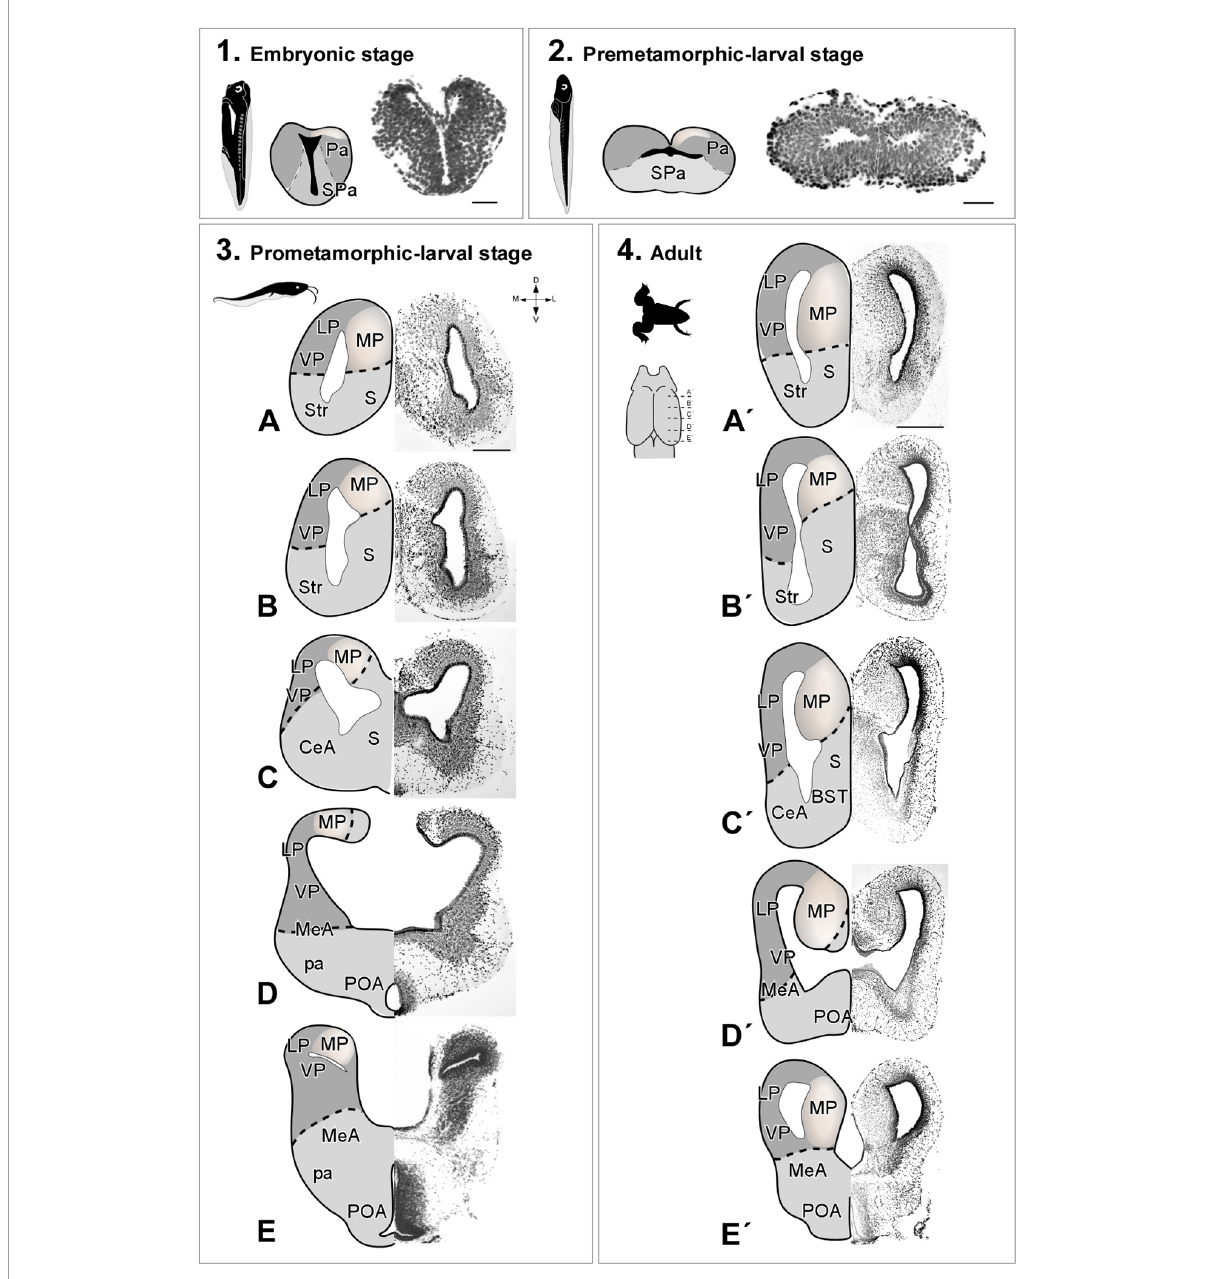
FIGURE1 Photomicrographs of transverse sections through the telencephalon of Xenopus laevis at embryonic (1) , premetamorphic (2) , prometamorphic larvae stages (3A–E) and adult (4A (cid:48) –E (cid:48) ) . Nissl staining allowed the anatomical identification of the medial pallium during embryonic stages prior to telencephalic evagination (1) or after evagination in premetamorphic (2) , prometamorphic (3) larval stages and adult (4) . The region of the medial pallium is pink-colored in the schematic drawings of telencephalon semi-hemispheres. Scale bar in 1 , 2 , (3A–E) = 200 µ m, (4A (cid:48) –E (cid:48) ) = 500 µ m. See the abbreviation list.